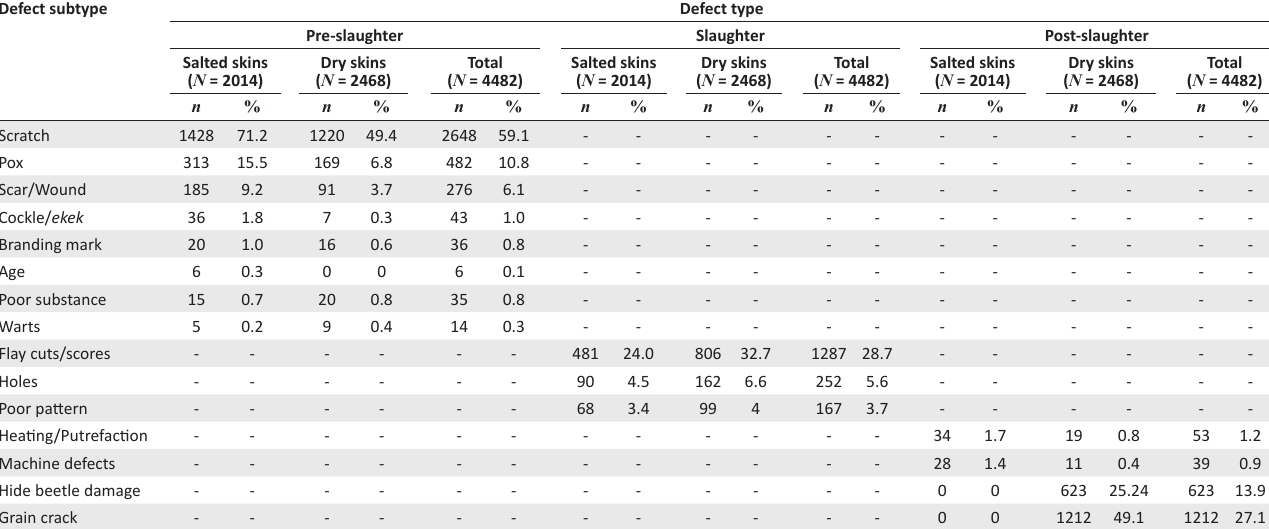
TABLE 2: Pre-slaughter, slaughter and post-slaughter defects of wet blue salted and dry goat skins from the Tigray region, Ethiopia. Defect